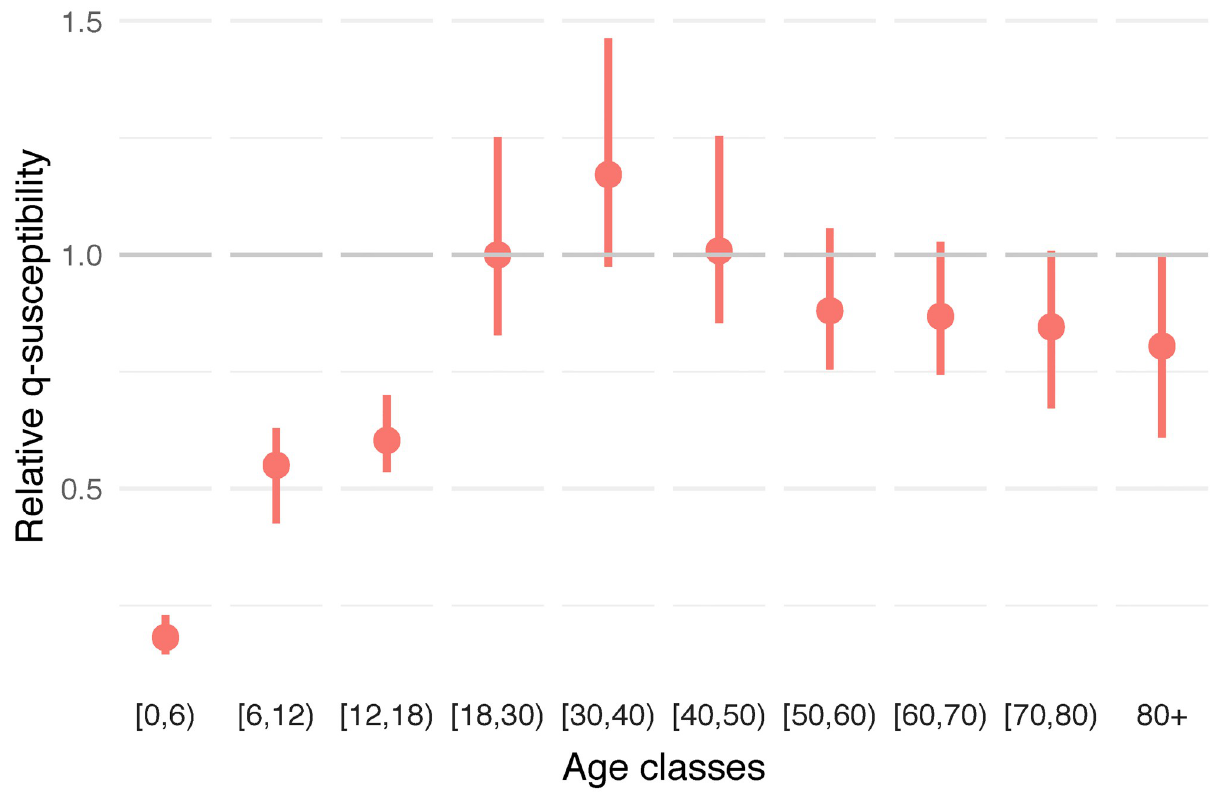
Fig 1. Estimated relative q -susceptibility. The estimation of q -susceptibility is performed by age class using the next generation principle under an assumption on age-specific infectiousness (0.54, 0.55, 0.56, 0.59, 0.7, 0.76, 0.9, 0.99, 0.99, 0.99). The calibration is performed on CoMix waves 12 to 23 (observation period: 22 December 2020 to 15 June 2021). Dots represent means and bars represent 95% percentile (nonparametric) bootstrap-based confidence intervals.